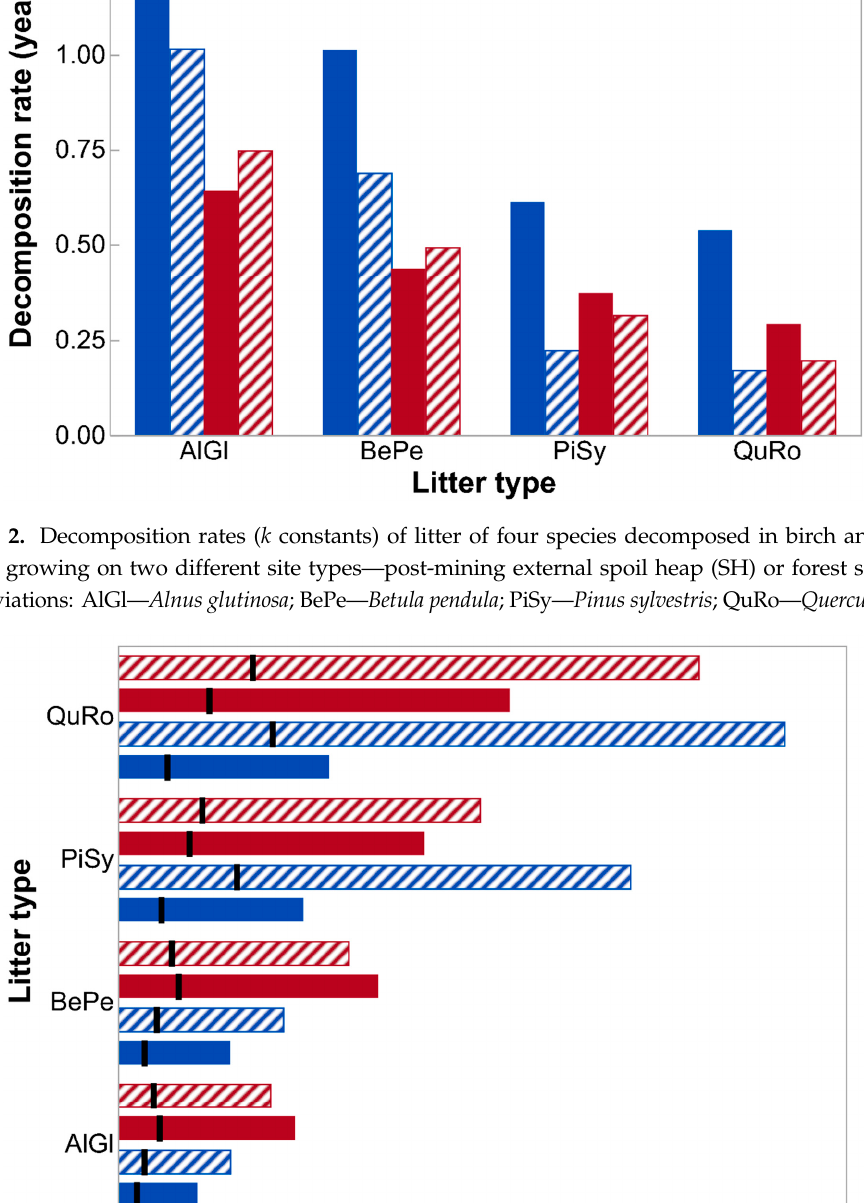
Figure 3. Total (bars) and half (black line) decomposition levels reached by specific leaf litter in specific stand-site conditions. Abbreviations: AlGl— Alnus glutinosa ; BePe— Betula pendula ; PiSy— Pinus sylvestris ; QuRo— Quercus robur ; SH—post-mining external spoil heap site, F—forest site.